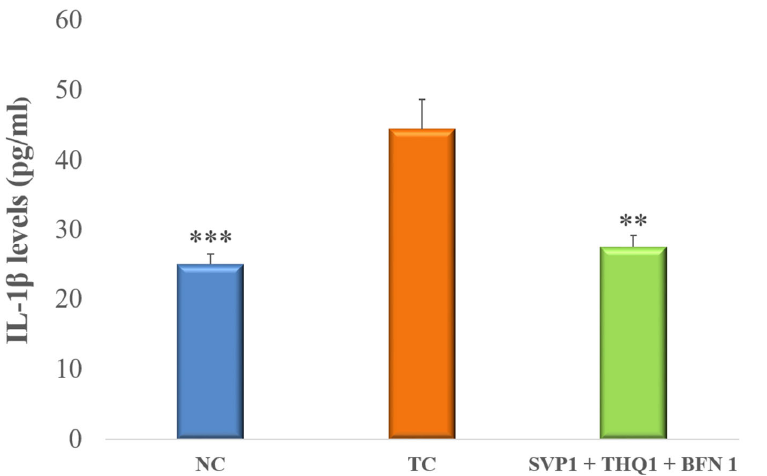
Figure 3. Effect of SVP (150 mg/kg) + BFN (5 mg/kg) + THQ (5 mg/kg) treatment on hippocampal levels of IL ‐ 1 β . The values are expressed as mean ± SEM. ** p < 0.01, *** p < 0.001 versus TC. NC; Normal Control, TC; Toxic Control.